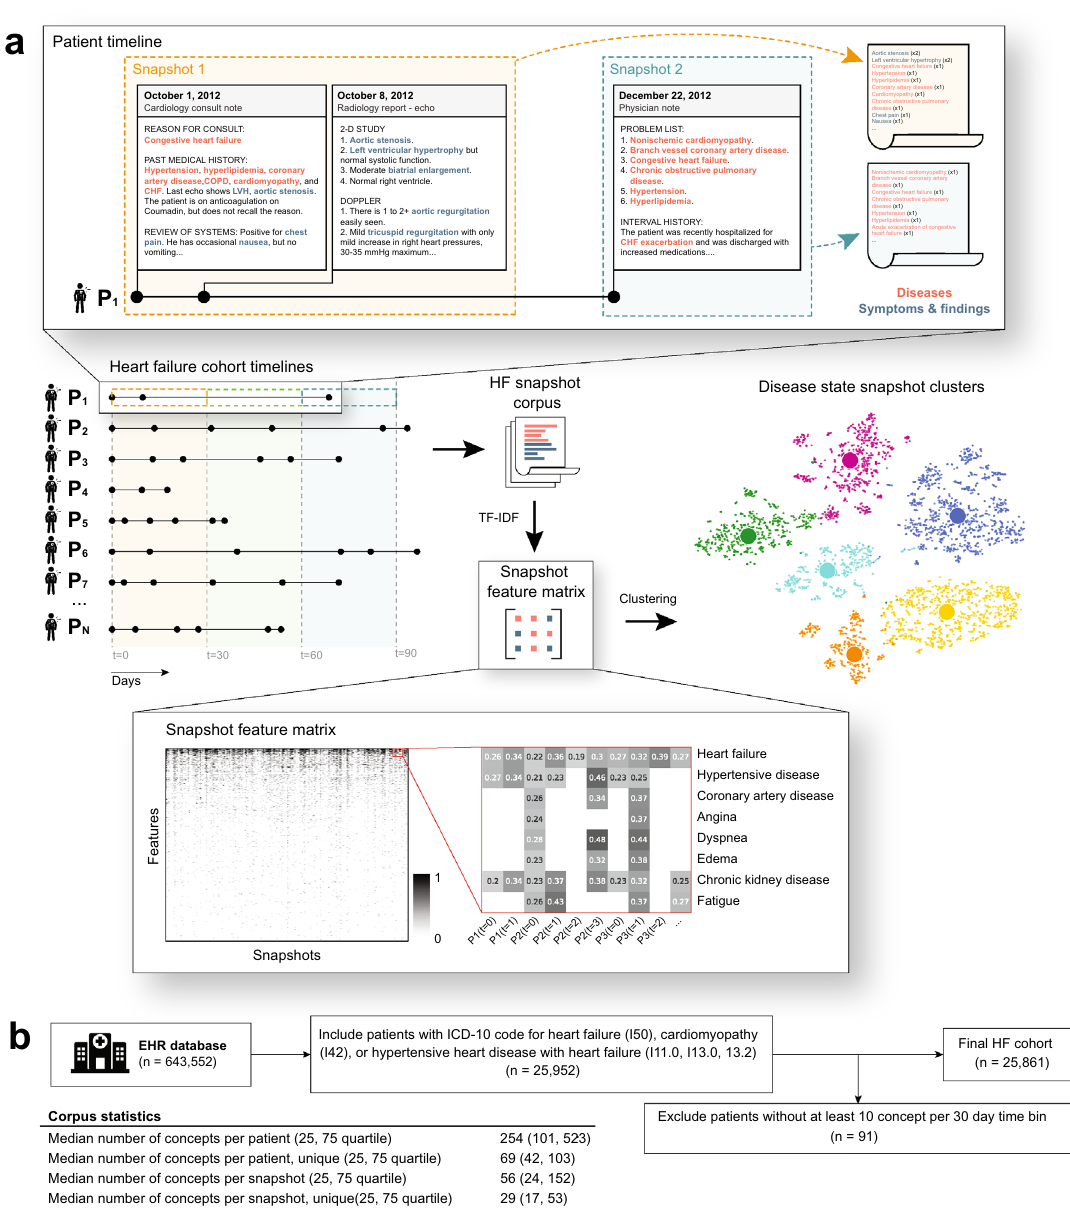
Figure 1. Workflow diagram for converting HF patient EHRs to disease state snapshot clusters. ( a ) Natural language processing was used to extract complaints from all the unstructured notes in each patient’s EHR. Complaints were aggregated within 30 day time bins (clinical state “snapshots”). The snapshots of the entire HF cohort were used as input to a clustering algorithm, which finds groups of similar patient snapshots and produces disease state clusters. ( b ) Inclusion/exclusion criteria and corpus statistics for the final HF